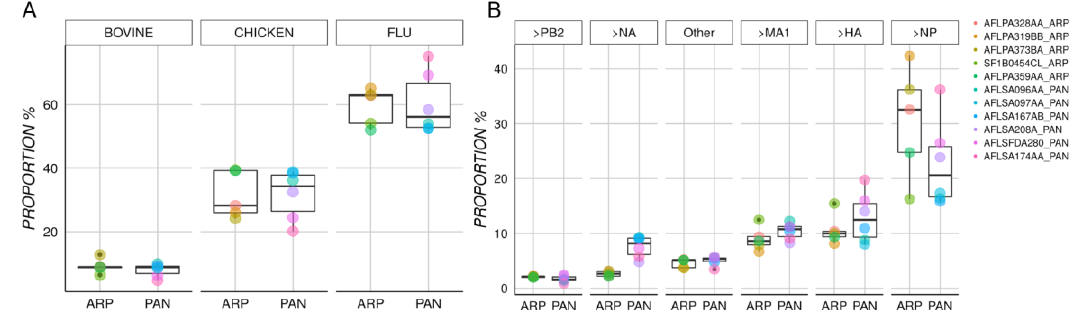
Figure 1. Protein composition in Pandemrix versus Arepanrix. ( A ) Boxplots for each type of protein, Table 1. ( B ) This figure shows the relative proportion or concentration of each protein type within each vaccine for peptide fragments classified as influenza proteins.